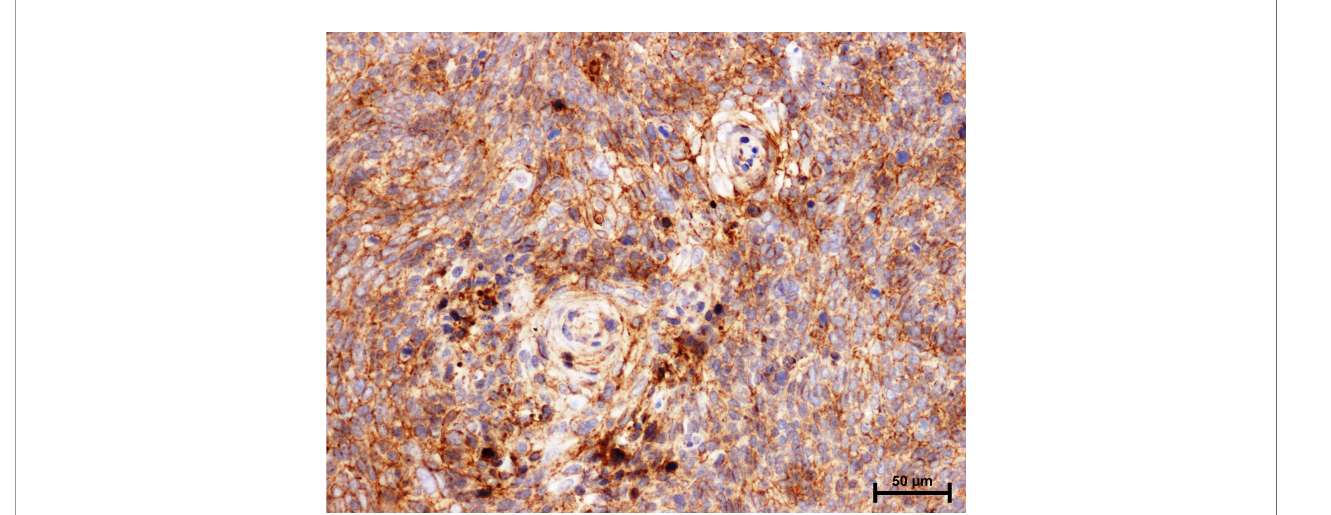
FIGURE 3 | Immunoidenti fi cation of b -catenin in warty – basaloid carcinoma of